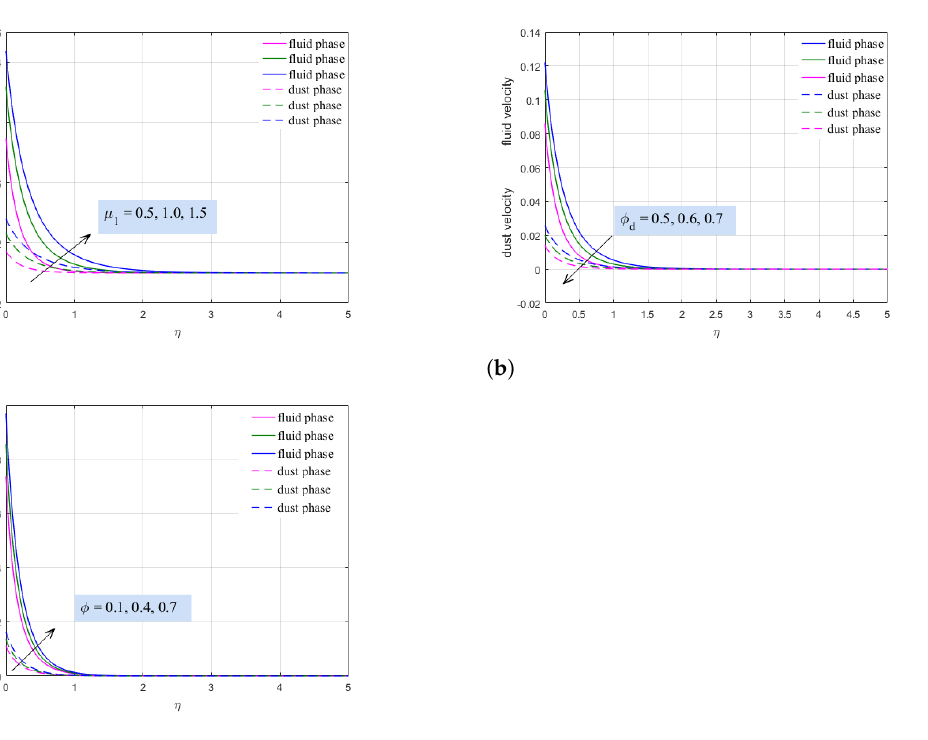
Figure 2. Velocity curves for different values of physical parameters. ( a ) Change in velocity at different values of µ 1 . ( b ) Change in velocity at different values of φ d . ( c ) Change in velocity at different values of phi